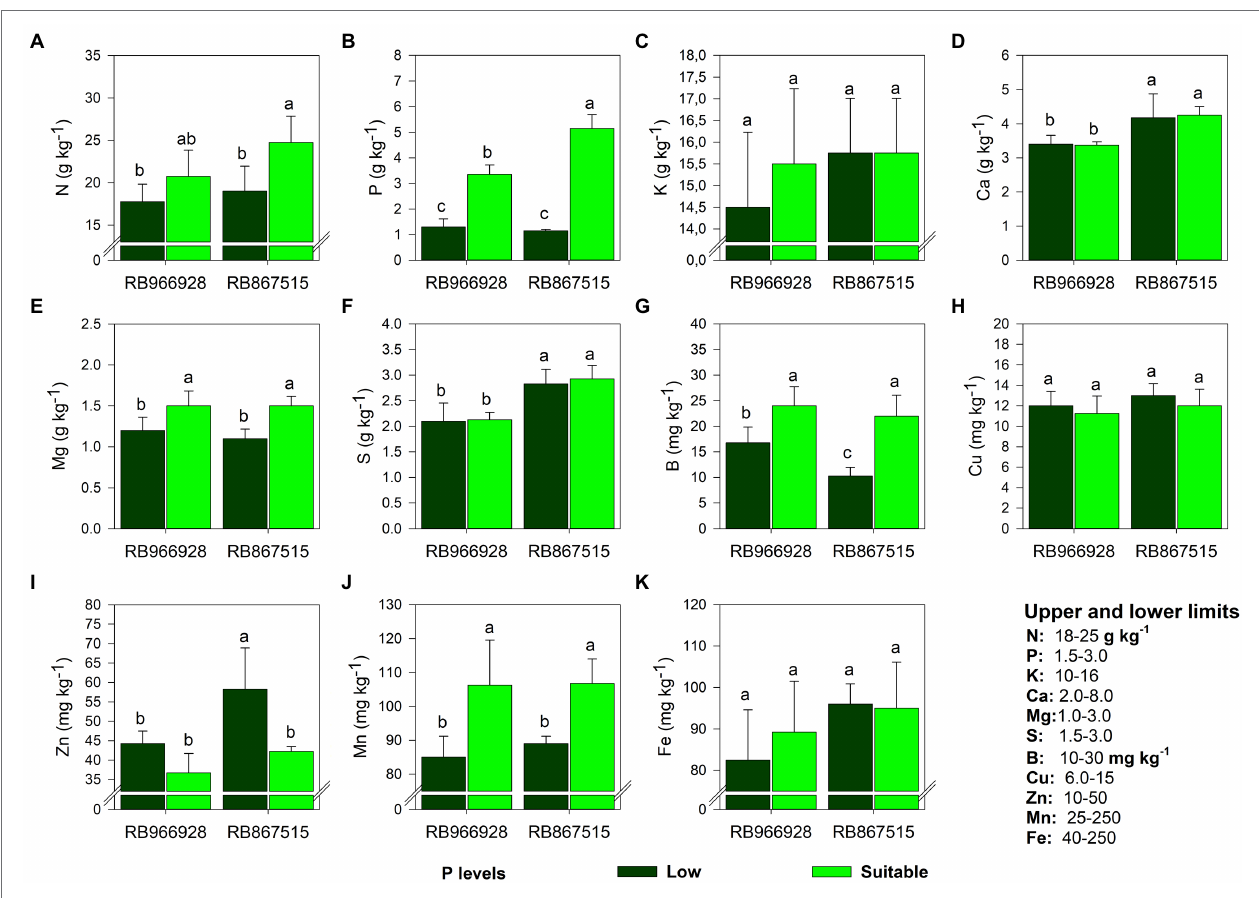
FIGURE 3 | Leaf concentration of (A) N, (B) P, (C) K, (D) Ca, (E) Mg, (F) S, (G) B, (H) Cu, (I) Zn, (J) Mn, and (K) Fe as a function of sugarcane RB966928 and RB867515 varieties and low and suitable P levels. Different letters indicate significant differences in sugarcane variety and P level by Student’s t -test at p ≤ 0.05. The error bars express the SE of the mean ( n =